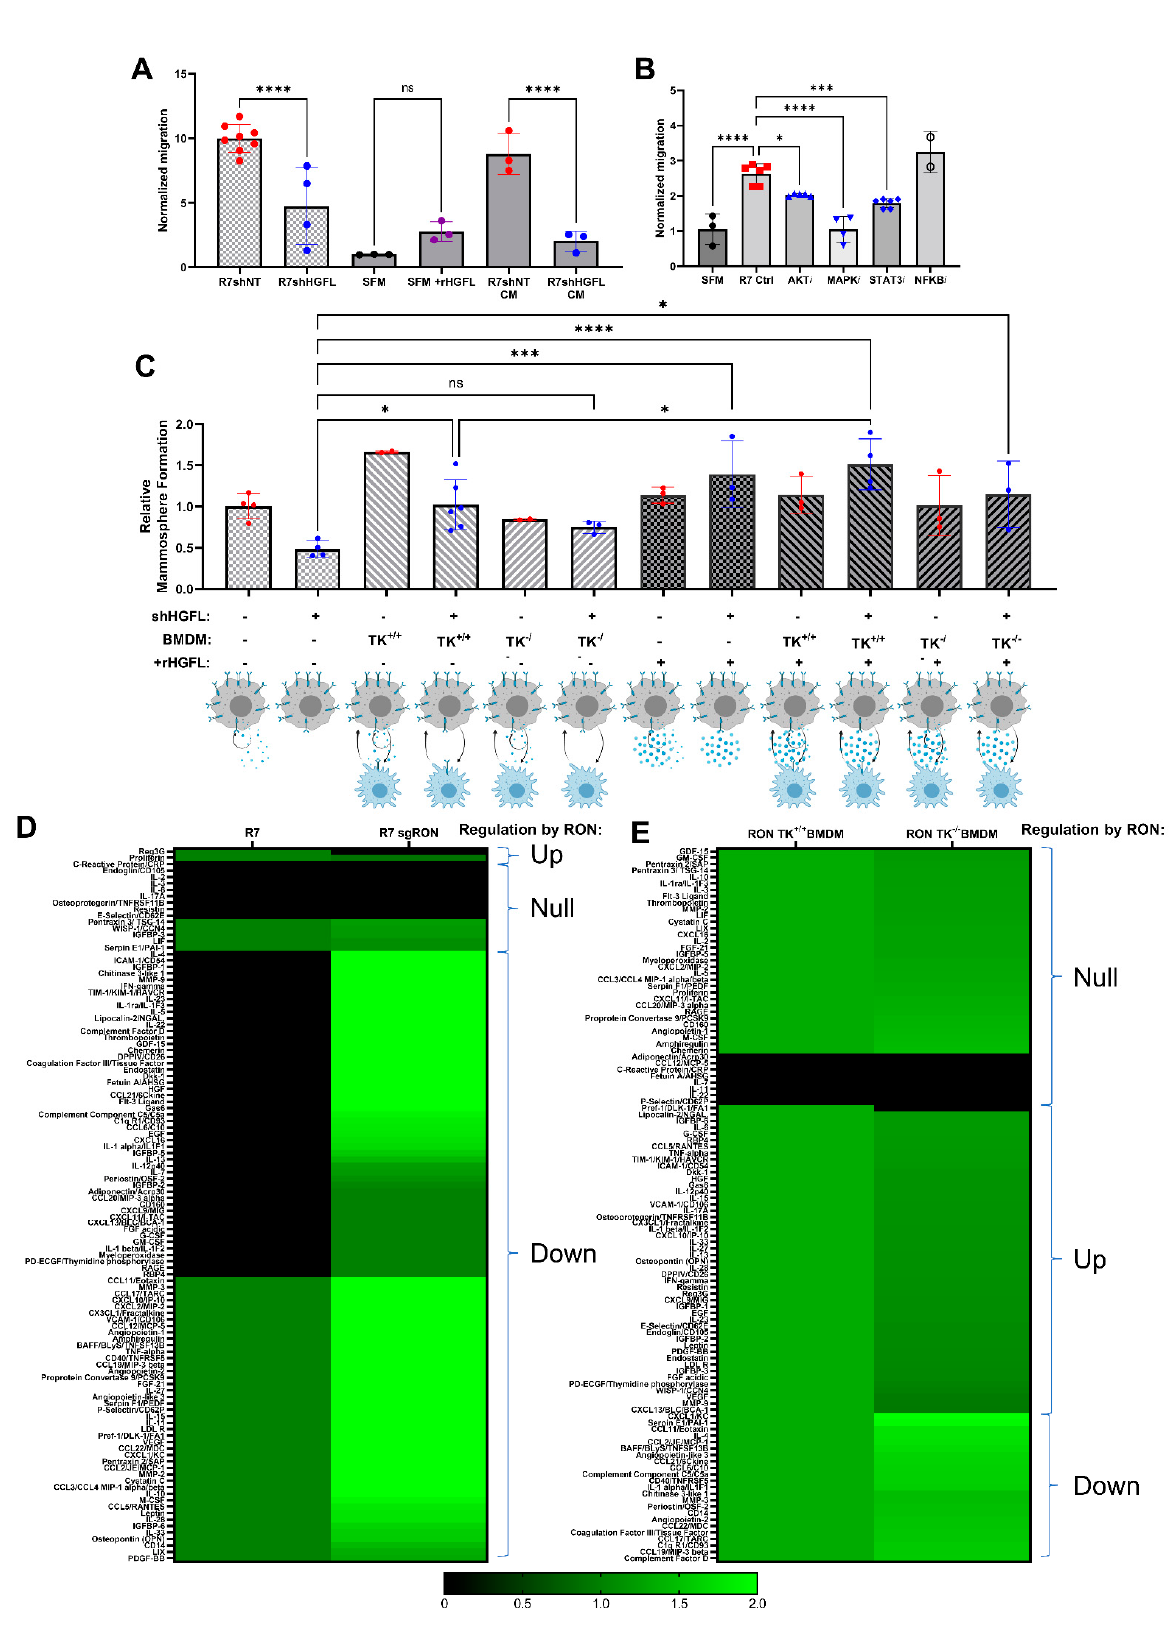
Figure 4. Loss of HGFL in breast cancer cells impairs mammosphere formation, macrophage migra- tion, and alters the secretome of both cell types. ( A ) Macrophage migration towards denoted stimulus including serum-free media (SFM), SFM + recombinant HGFL (rHGFL, 50ng/mL), conditioned